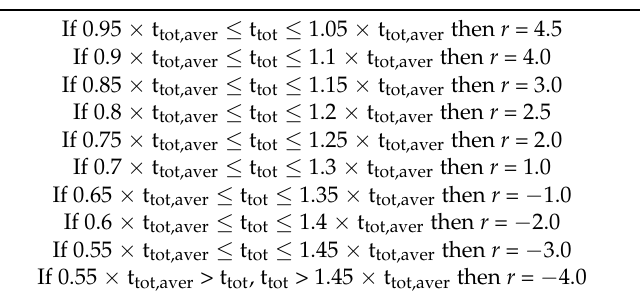
Table 2. Immediate reward (r)